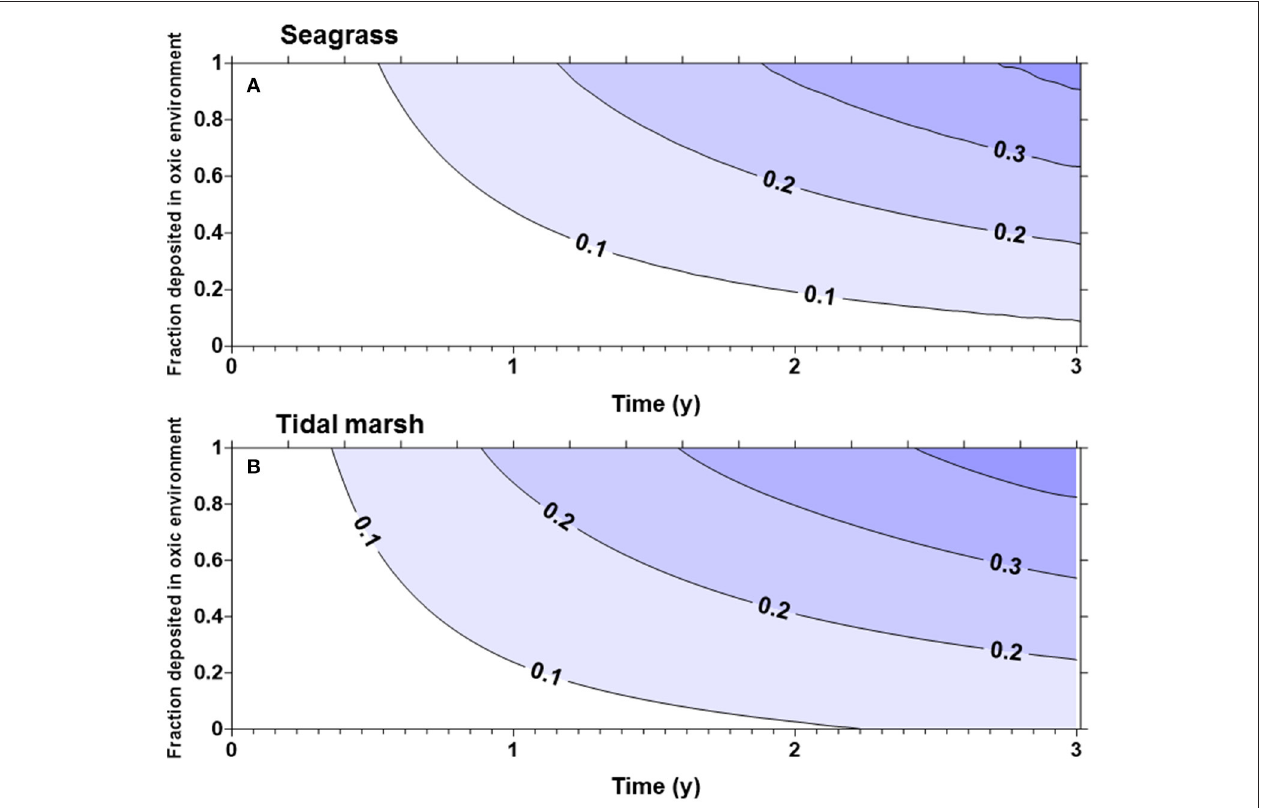
FIGURE 1 | Fraction of the original organic carbon contained in the biomass and top meter of sediment in a seagrass bed (A) or tidal marsh (B) , emitted as a function of time and α , the fraction deposited in oxic environments. More than 40% of the original organic matter will be remineralized in 3 years if all of the organic matter is deposited in oxic